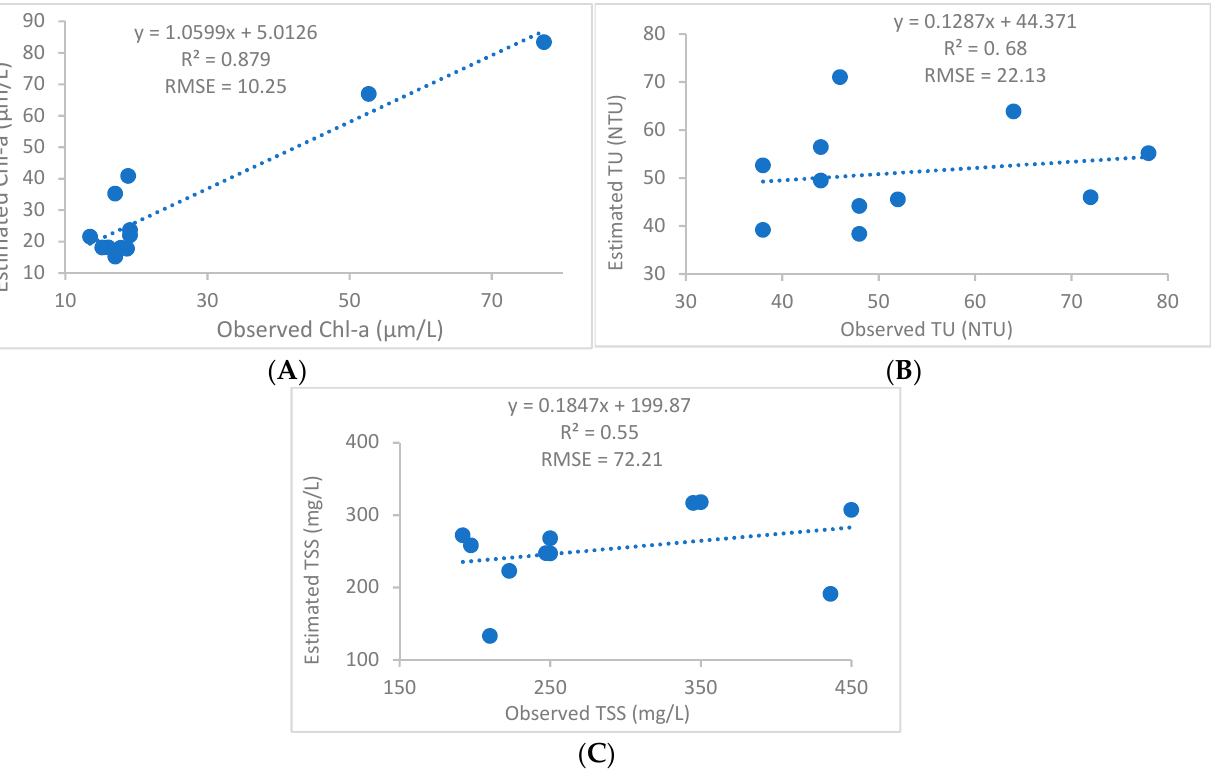
Figure 7. Prediction and validation of Chl-a , TU, and TSS with Sentinel-2A band (band ratio). ( A ) Observed and estimated Chl-a concentration band ratio (B5/B4). ( B ) Observed and estimated Turbidity (band ratio B4/B3), and ( C ) observed and estimated TSS (B4) within the reservoir, using Equations (9)–(11), respectively.